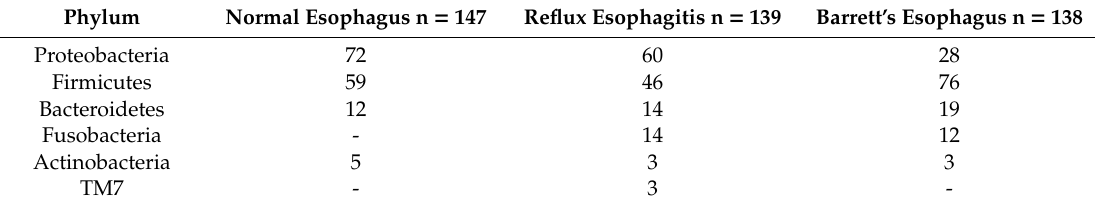
Table 1. Di ff erences in esophagus microbiota between patients with Barrett’s esophagus, reflux esophagitis, and healthy subjects (distribution of clones at the phylum